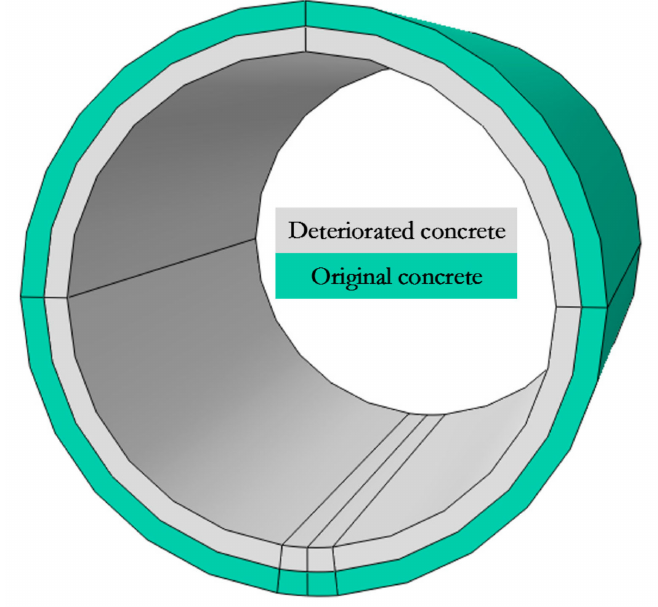
Figure 4. FEM model of half-deteriorated cable